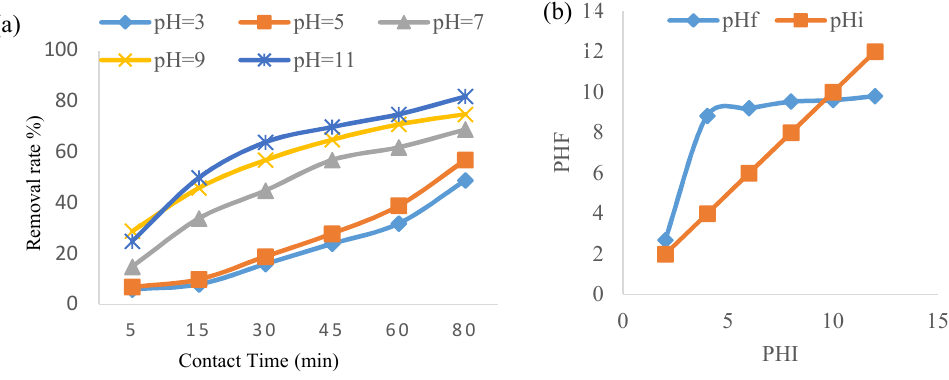
Fig. 5. (a) The effect of solution pH on the adsorption of lead by the MBAS (lead solution = 10 mg/L min, 318 ºK, and adsorbent conc. = 0.5 g/L) and (b) pH zpc of the sorbent